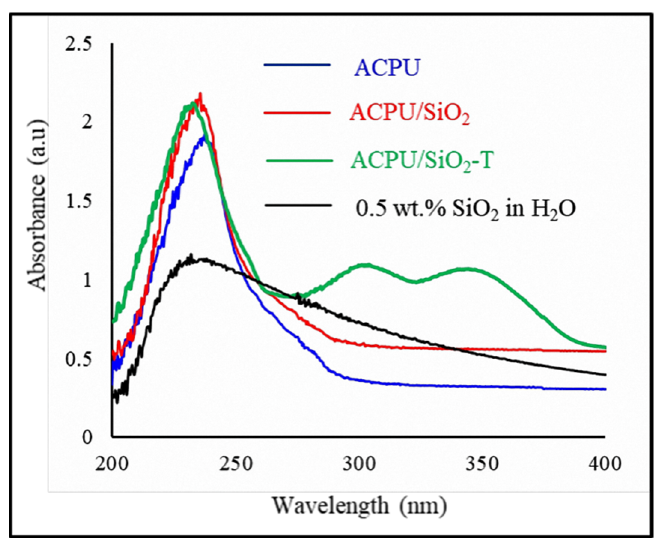
Figure 9. Ultraviolet-visible (UV-Vis) spectra of the various coating samples and the aqueous solution of nano-SiO 2 .